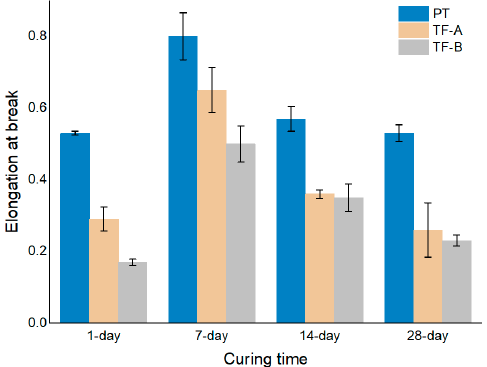
Figure 11. Comparison of elongation at break.